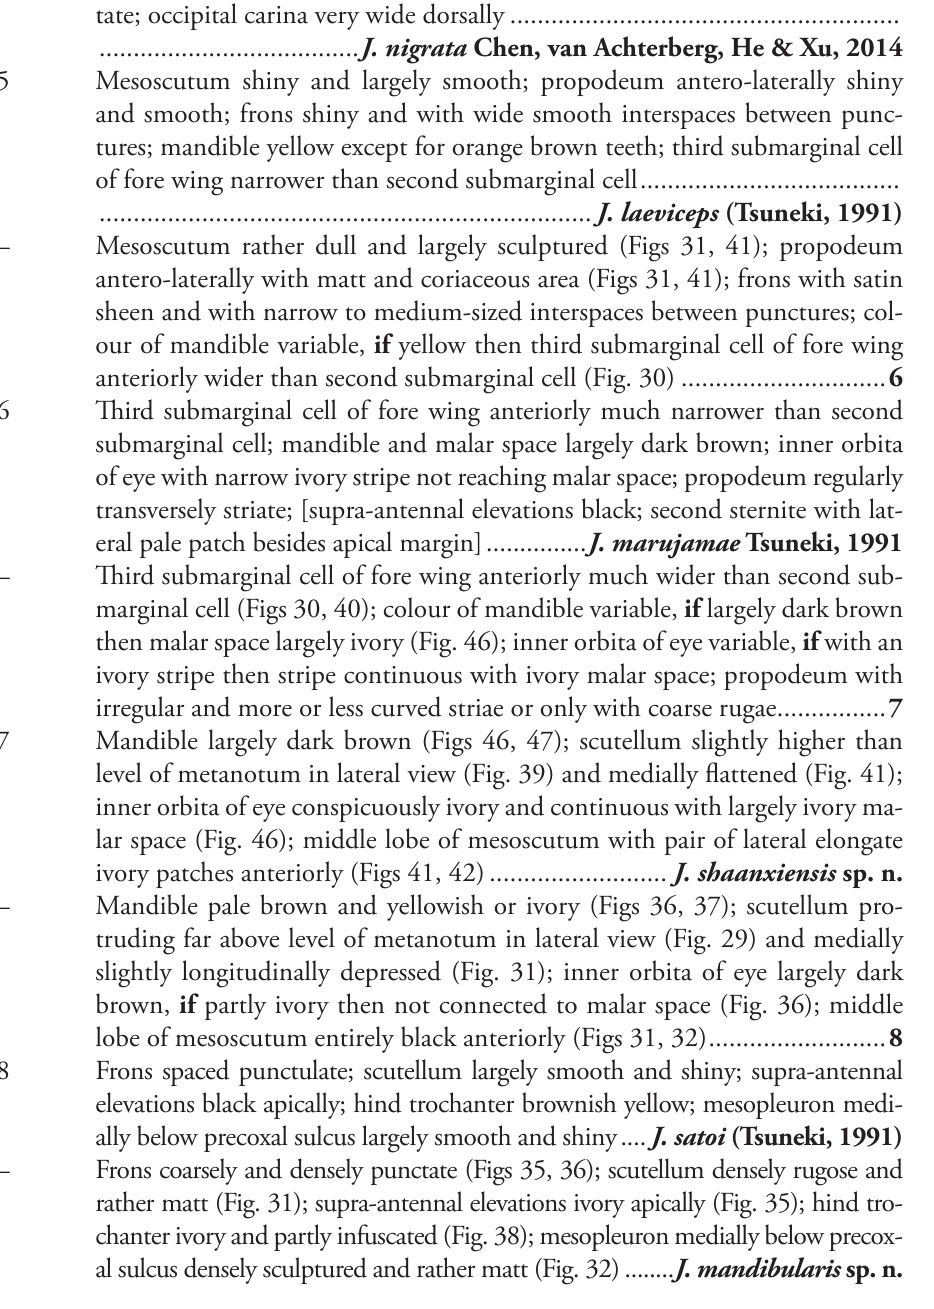
Supra-antennal elevations largely yellow; frons and vertex sparsely and finely